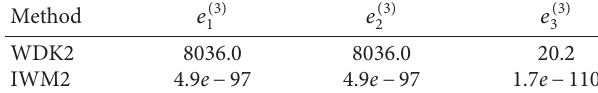
Table 5: Simultaneous finding of all roots.